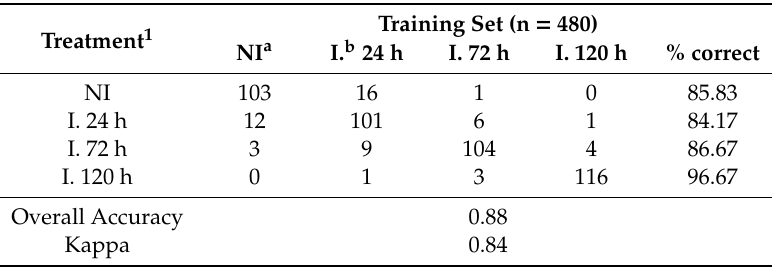
Table 2. Confusion matrices of the LDA model in training and testing sets using color and texture resources of black oat seeds obtained at 19 wavelengths (365 to 970 nm) for class membership of non-inoculated (NI) and inoculated seeds (I) with Drechslera avenae (Eidam) Sharif for 24, 72 and 120 h. Training Set (n = 480) Treatment 1 NI